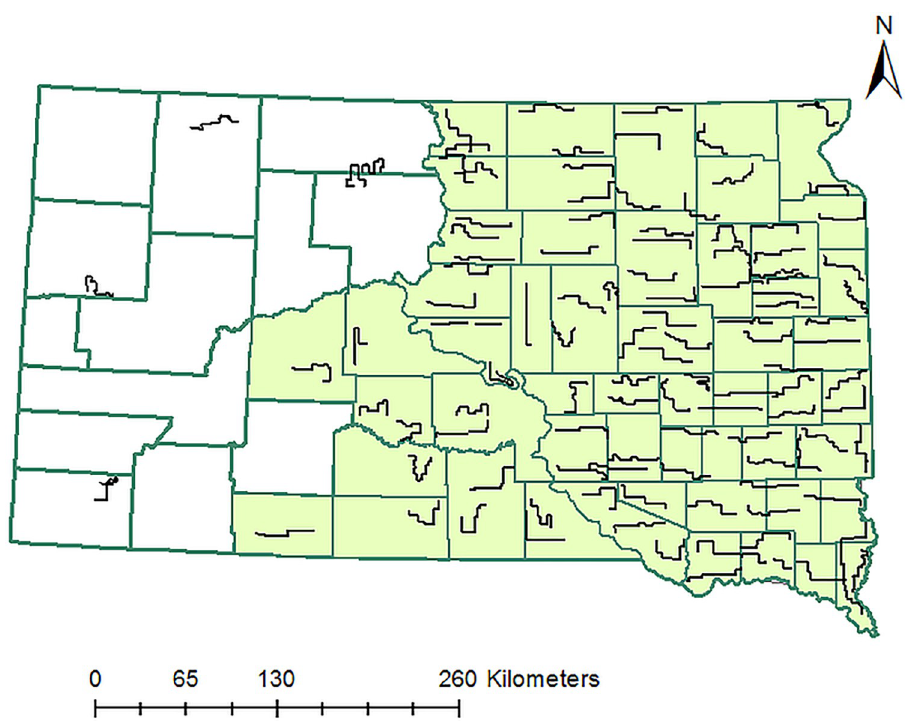
Fig 1. Distribution of roadside survey routes used to index the relative abundance of pheasants in South Dakota; data collected along the 105 survey routes within the highlighted 53 counties were used to assess factors driving pheasant productivity between